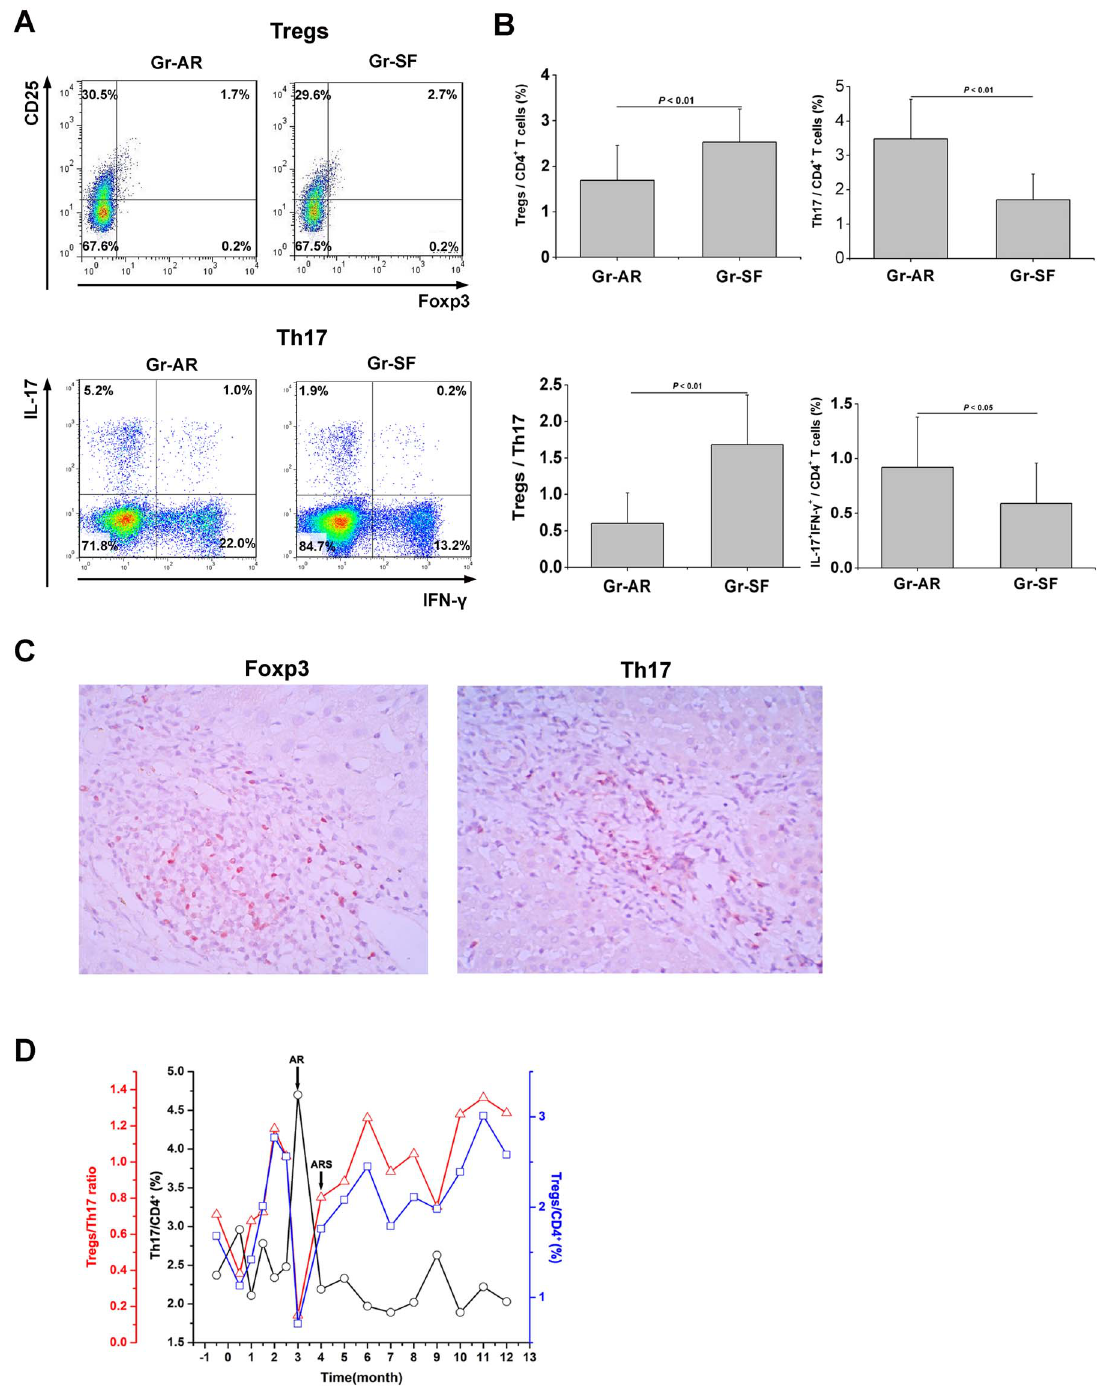
Figure 1. The distribution of Tregs and Th17 cells in the peripheral blood and in the grafts of patients with acute allograft rejection. (A) Representative profiles of Tregs and Th17 cells in peripheral blood collected using fluorescence-activated cell sorter (FACS). (B) The frequency of Tregs and Tregs/Th17 ratio were significantly higher in Gr-SF than in Gr-AR. On the contrary, the frequency of Th17 cells was significantly lower in Gr- SF than in Gr-AR. In addition, the frequency of IL-17 + IFN- c + cells was lower in Gr-SF than in Gr-AR. (C) To evaluate the distribution pattern of Tregs and Th17 cells in allografts with acute rejection, we examined the infiltration of Tregs and Th17 cells using immunohistochemical staining. Anti-FoxP3 + and anti-IL-17 antibodies were used on paraffin embedded biopsy samples which were obtained from allograft with acute rejection. The results showed extensive infiltration of Tregs (red) and Th17 cells (red). Original magnification, 6 400. (D) One representative patient with acute allograft rejection was followed-up for 12 months after liver transplantation. The dynamics of Tregs and Th17 cell frequencies were depicted during the follow- up period (the black line represents Th17 cells frequency; the blue line the Tregs frequency; and the red line Tregs/Th17 ratio). ARS: Acute rejection subsided.